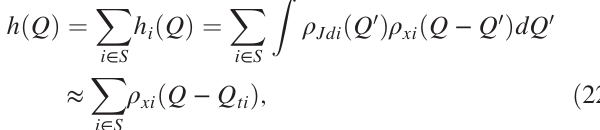
FIG. 5. The horizontal and the vertical emittances versus the turn number for the off-resonance and the coupling resonance cases for q ¼ 7 . 94 . The emittances are nearly constant, the relative change being smaller than 5 × 10 − 4